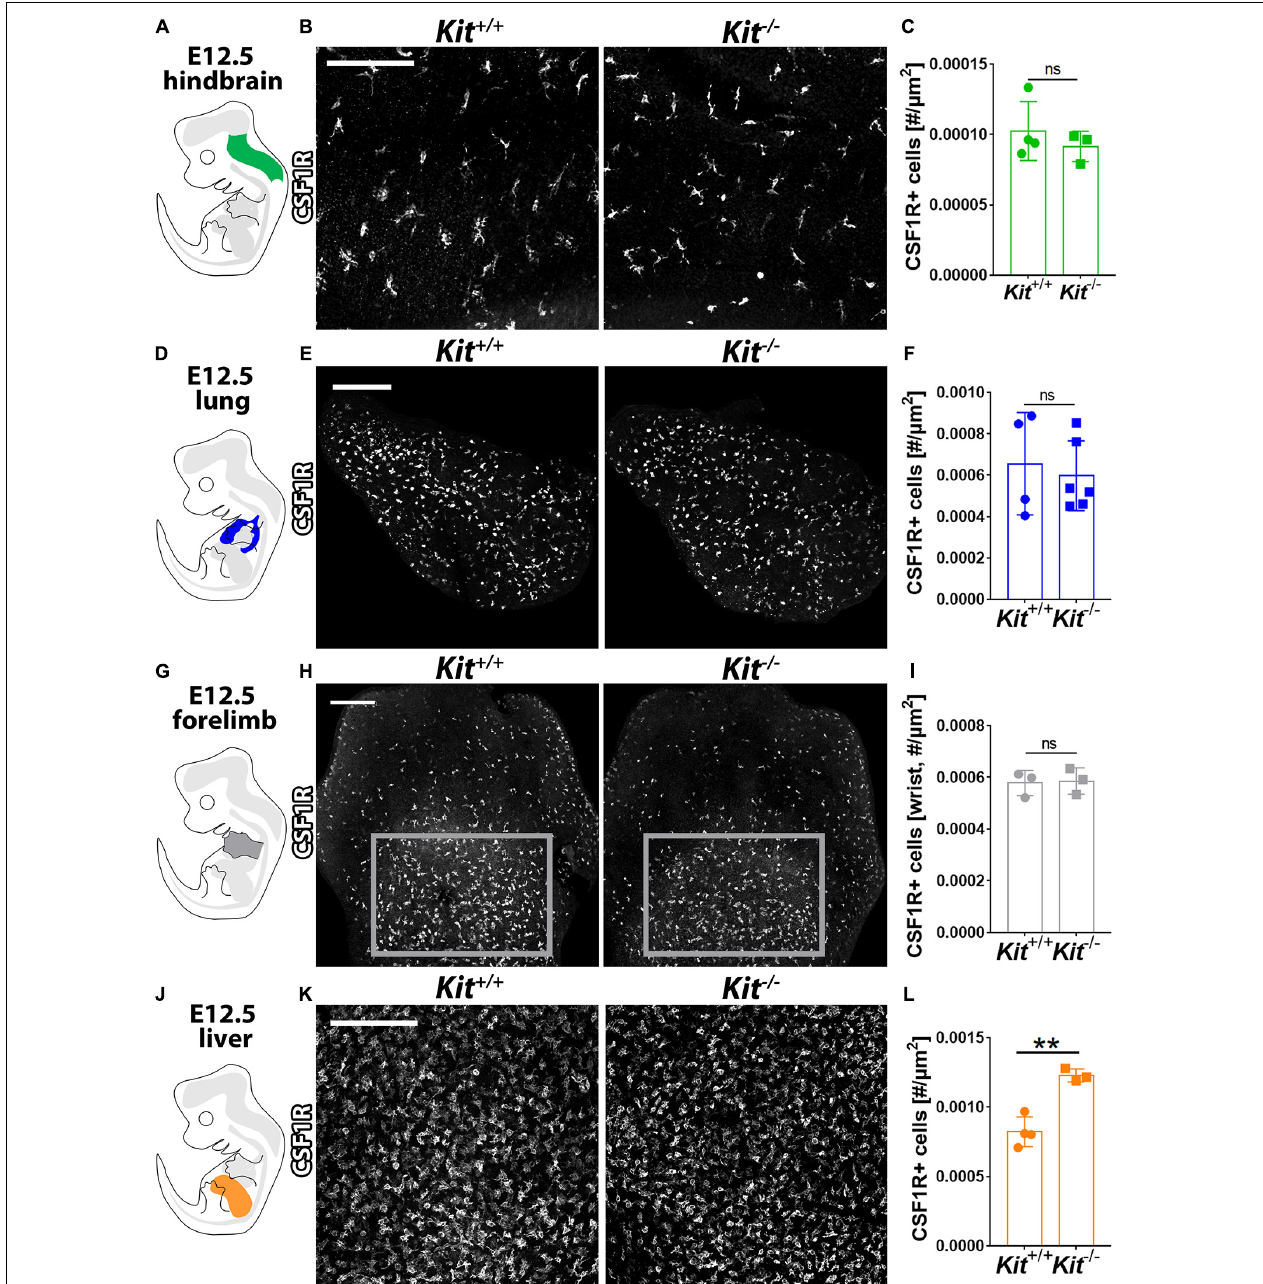
FIGURE 3 | KIT loss does not affect yolk sac-derived macrophage colonization of embryonic brain, lung, and limb but promotes their expansion in the liver. E12.5 mouse hindbrain (A–C) , lung (D–F) , forelimb (G–I) , and liver (J–L) from Kit + / + versus Kit − / − littermates were whole mount stained for CSF1R, imaged by confocal microscopy, and shown in gray scale. Scale bars: 200 µ m. In (H) , the areas indicated with gray rectangles indicate the regions used for the quantification of CSF1R + macrophages in the wrist area of the forelimb. Quantification of CSF1R + macrophages: n = 4 wild-type and 3 mutant hindbrains from three litters (C) , n = 4 wild-type and 6 mutant lungs from three litters (F) , n = 3 each for forelimbs from two litters (I) , and n = 4 wild-type and 3 mutant livers from three litters (L) . Bar graph data are shown as mean ± SD; each data point represents the value from one embryo; ns, non-significant; ** p < 0.01 (unpaired Student’s t -test).